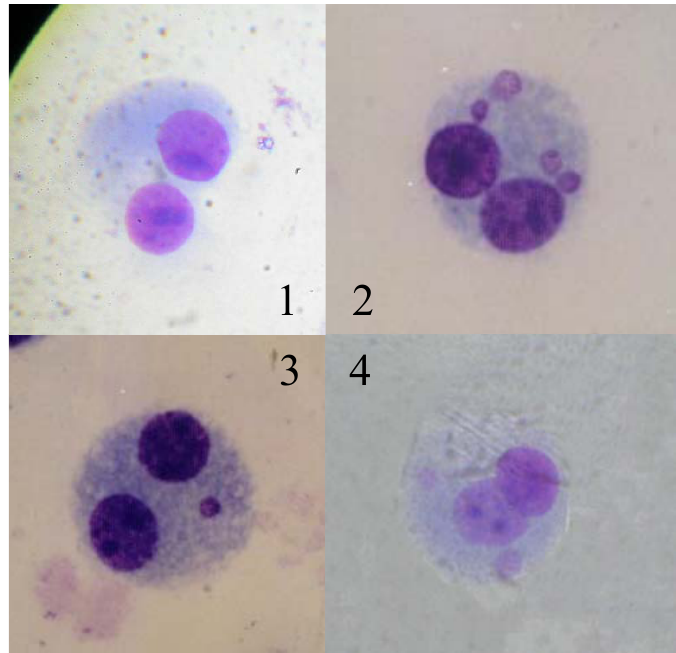
Figure 2. Cytokinesis-blocked micronuclei in lymphocytes from three cases of a radiation accident. 1 , A normal, binucleated lymphocyte; 2 , A binucleated lymphocyte with four micronuclei from Case A; 3 , A binucleated lymphocyte with one micronucleus from Case B; 4 , A binucleated lymphocyte with two micronuclei from Case C.